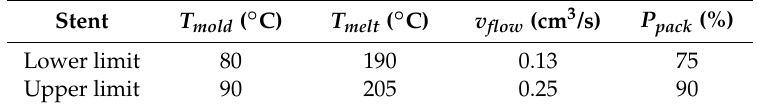
Table 1. The range of the process